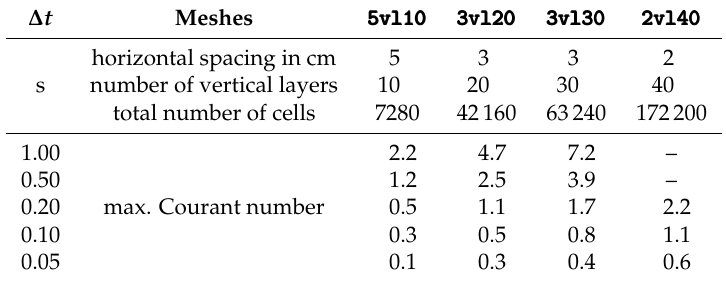
Table 1. Meshes, time step and approximate maximum Courant number for the mesh sensitivity analysis. ∆ t Meshes